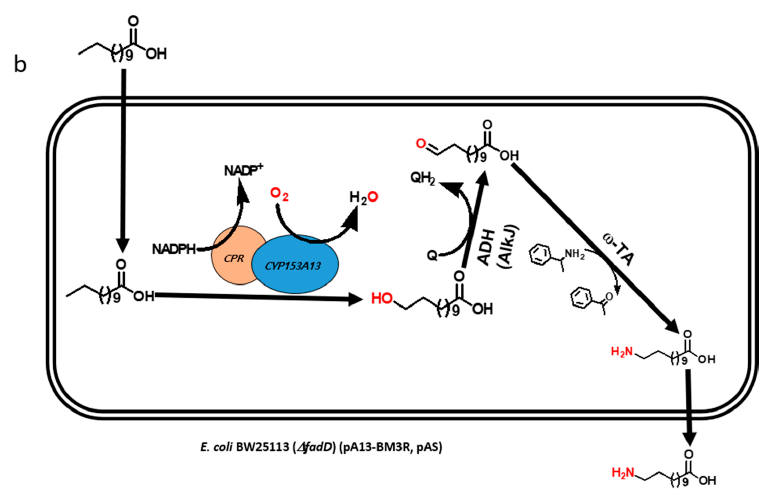
Figure 1. Schematic diagram showing the biosynthesis of ω -amino dodecanoic acid ( ω -AmDDA) from dodecanoic acid (DDA) using ( a ) three-protein system (previous study [10]) and ( b ) a single-protein system (this study) for ω -hydroxylation of DDA.